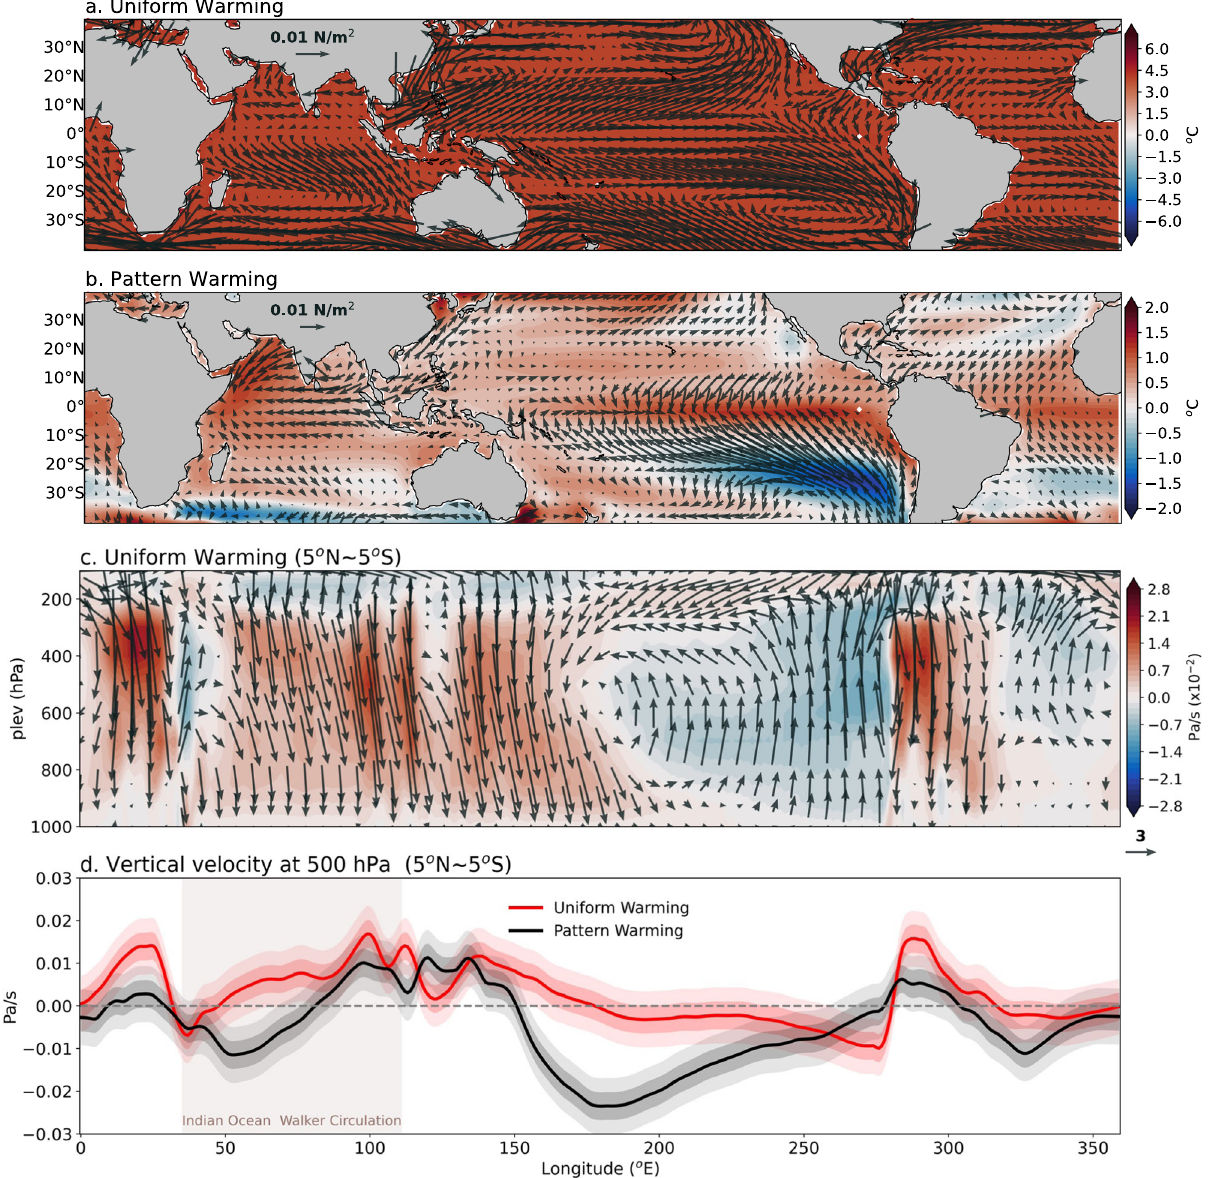
Fig.5|Circulationchangesintheuniformandpatternseasurfacetemperature (SST) warming experiments in atmosphere-only model simulations. Multi- model ensemble mean changes in surface temperature (shaded, °C) overlain with surface wind-stress (vectors, N/m 2 ) in a uniform SST warming experiment, b pattern SST warming experiment. c The multi-model ensemble mean longitude- height cross-section (5°N~5°S) of vertical velocity (Pa/s, shaded) and zonal-vertical velocity (vectors) from 1000 to 100 hPa in uniform SST warming experiment. The